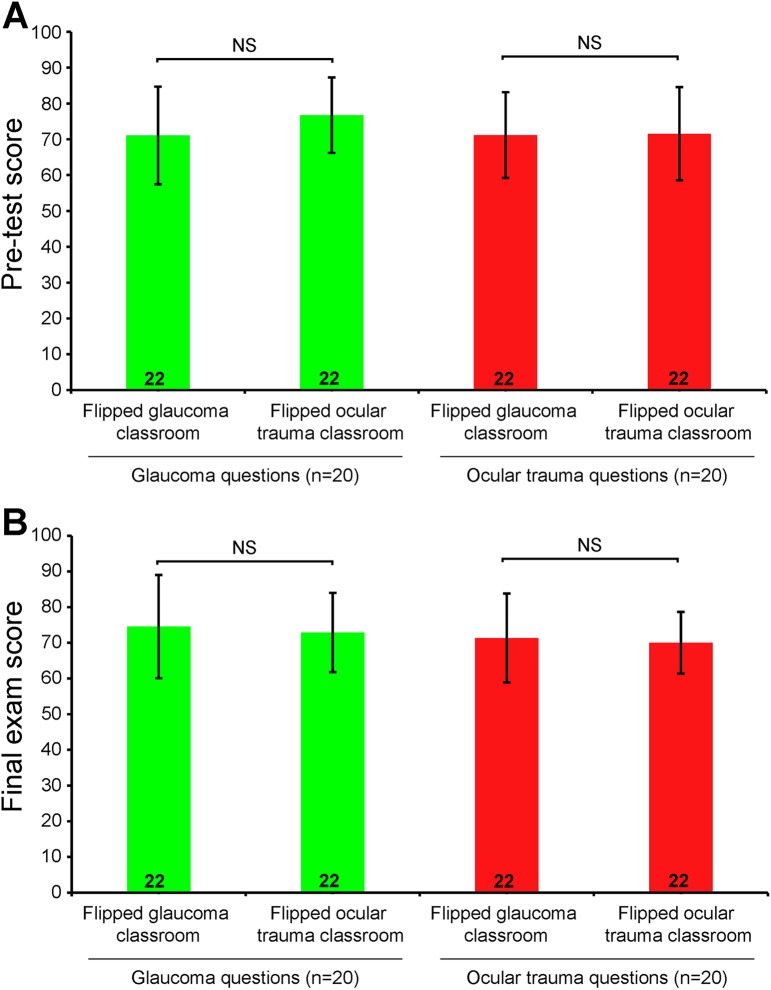
Comparison of students’ exam scores before and after the classroom.Students were asked to answer 20 glaucoma and 20 ocular trauma multiple choice questions before (A) and after (B) taking the classroom. Each question had the same weight, and the total score was converted into a 0–100 scale. Independent samples t test was used to compare the differences between the two groups. All data were presented as mean± S.D. n = 22.